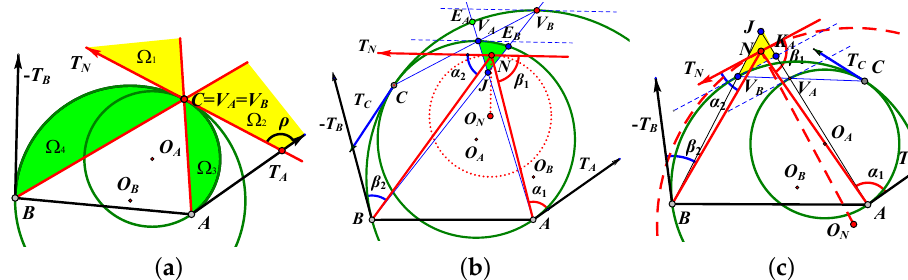
Figure 10. ( a ) T N = T C ; ( b , c ) inserting point N when C ∈ G .